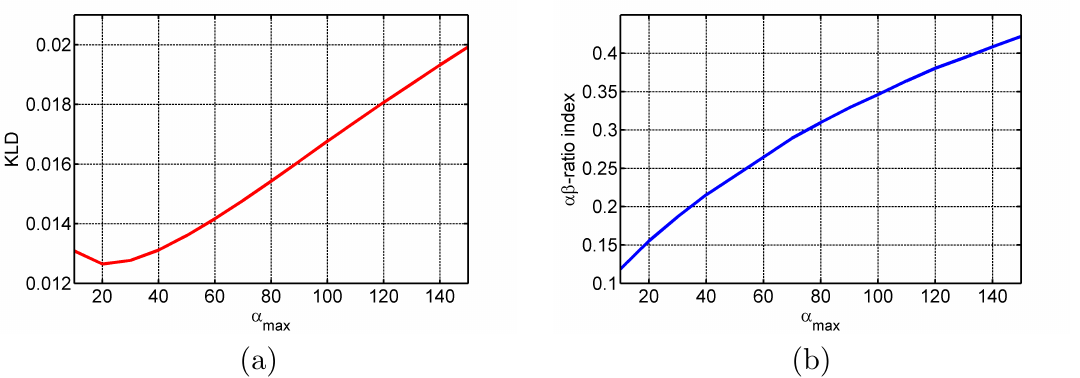
Figure 16. Chicago test case. Evolution of: ( a ) the KLD measure and ( b ) αβ -ratio index, as a function of the α max variation for the EWF